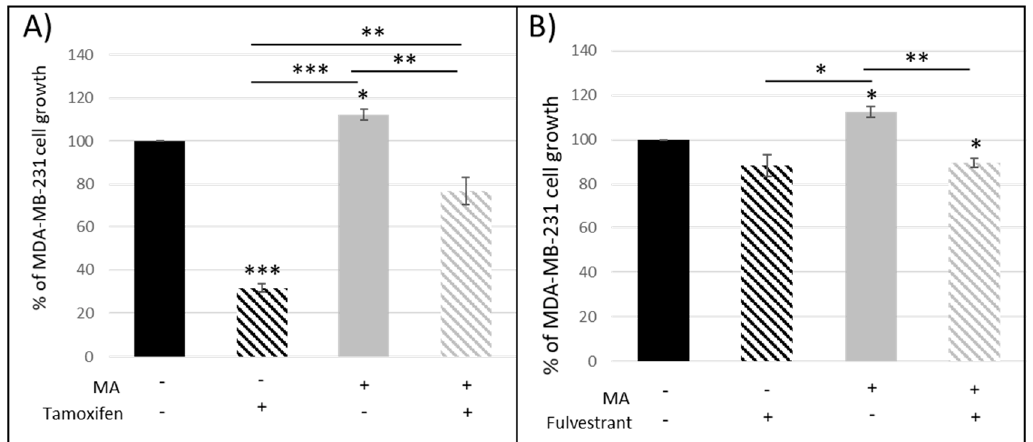
Figure 2. Percentage of MDA-MB-231 cell proliferation when co-cultured with mature adipocytes (MA) in the presence of tamoxifen ( A ) and fulvestrant ( B ) ( n = 3, * p < 0.05, ** p < 0.01, *** p < 0.001). Both co-culture and Tx treatment are responsible for specific gene expression profile.